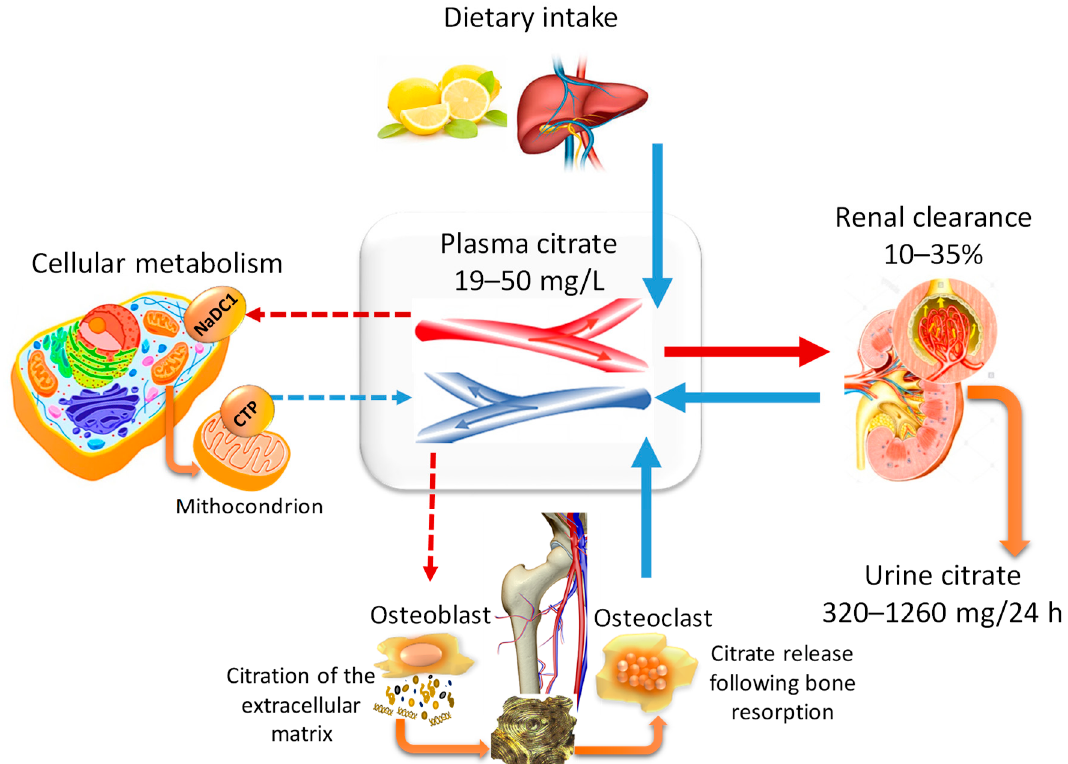
Figure 2. The four domains of citrate homeostasis. The plasma level of citrate mainly depends on four sources, i.e., nutritional intake, renal clearance, cellular metabolism, and bone remodelling. Food citrate is rapidly introduced into the circulation, filtered at the glomerular level, and eventually reabsorbed according to physiological needs. The citrate uptake from the extracellular milieu may occur only when specific transporter proteins are expressed, i.e., sodium-dicarboxylate (NaDC)1 belonging to the “solute carrier” 13 (Slc13) family. The citrate produced by mitochondria only marginally contributes to citrate homeostasis, since it is almost all used by cells as an energy source, or for the synthesis of lipids and other specific functions, i.e., citration of the extracellular matrix by the osteoblasts. In fact, the bulk stored in bone is the main endogenous source of citrate which becomes available following the resorption of the mineralised matrix by the osteoclasts. The mitochondrial citrate-transport protein (CTP) is essential for the release of citrate from the mitochondria to cytosol.